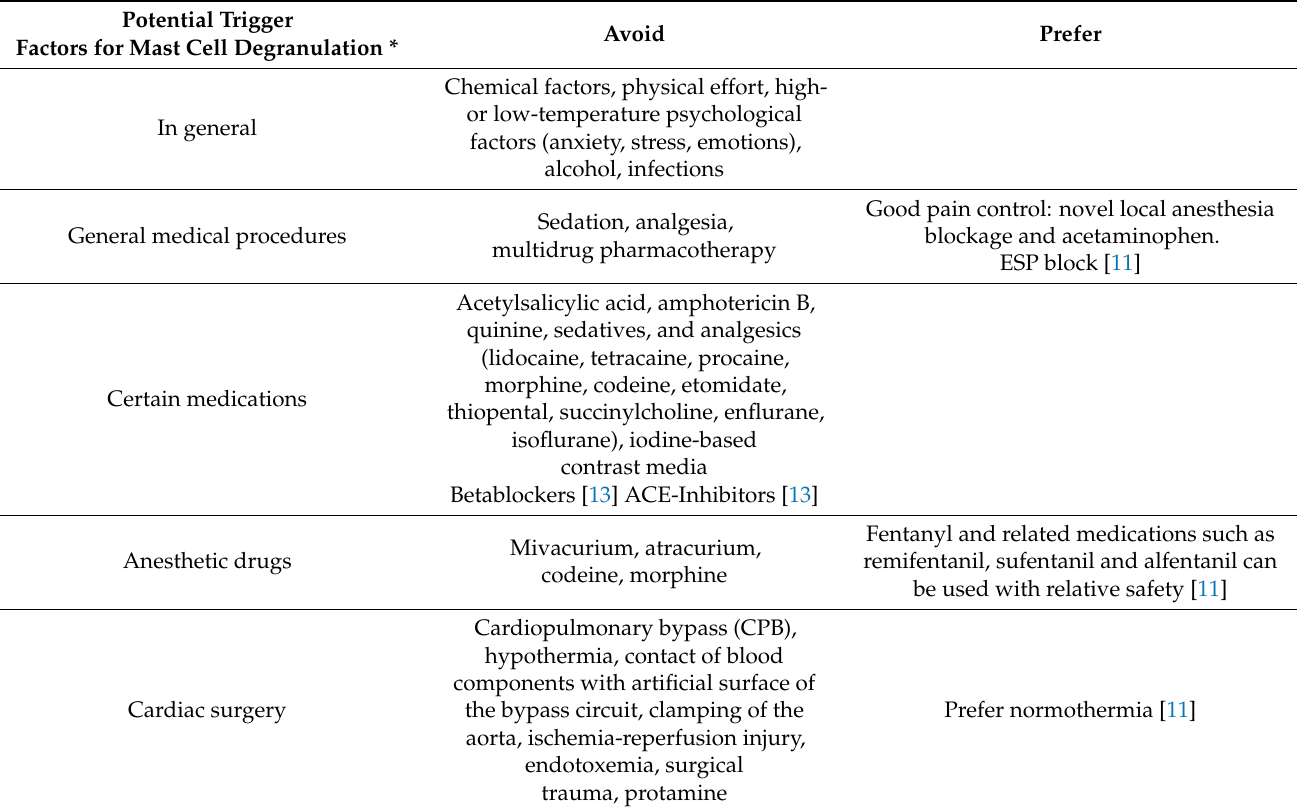
Table 6. Overview of potential triggers of mast cell degranulation and how to prevent